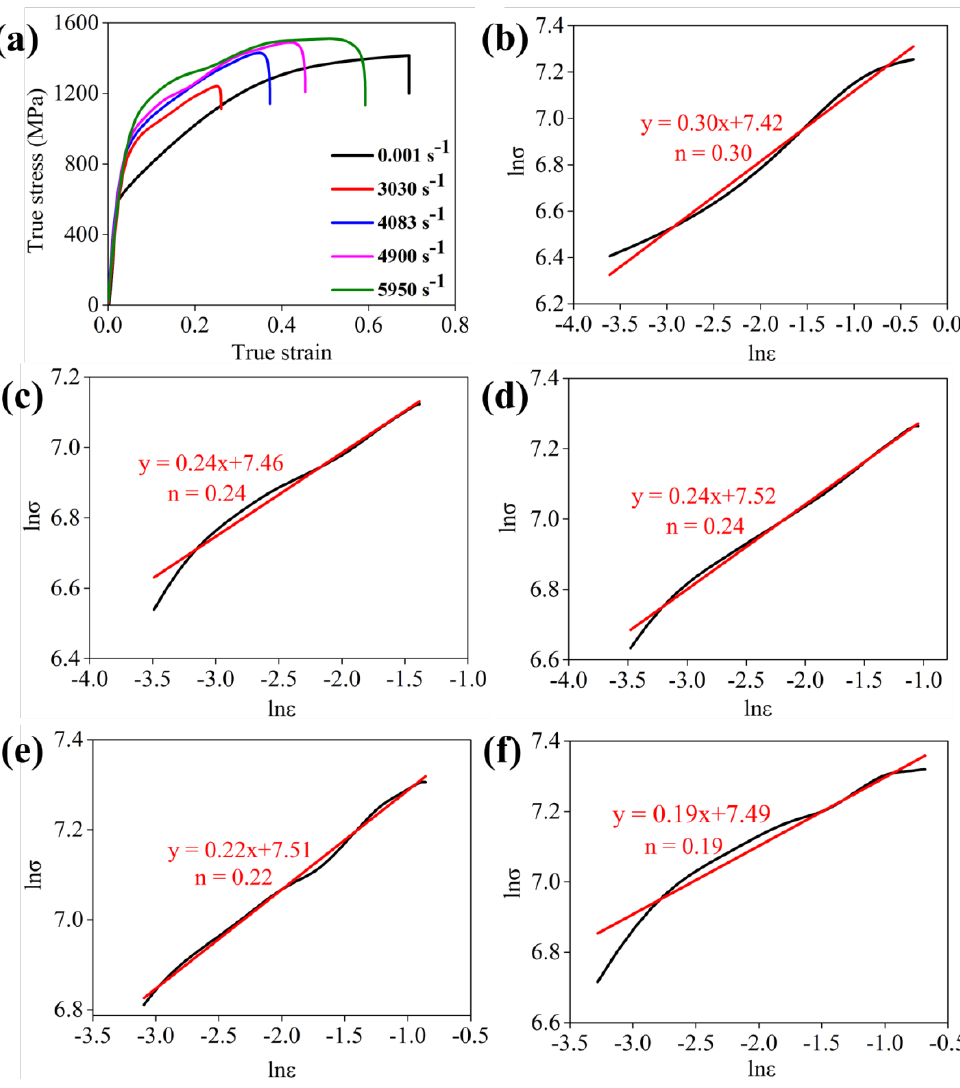
Figure 2. ( a ) Stress – strain curves under given conditions; ( b – f ) strain hardening exponent graphs at 0.001 s − 1 , 3030 s − 1 , 4083 s − 1 , 4900 s − 1 and 5950 s − 1 , In order to evaluate the stress – strain behavior under both conditions, we have eval- uated the strain hardening exponent ( n -value), strain rate sensitivity ( m -value) and adia- batic temperature rise. For evaluating the n-value, the following equation was employed. = n K (1) Here, σ and ε represent true stress and true strain, respectively, K represents the strain hardening coefficient, and n is the strain hardening exponent. By taking the loga- rithm (ln) of Equation (1), we are arrived at; ln ln ln n K = + (2) The value of n can be calculated by making a linear regression analysis of ln σ and ln ε . After thorough analysis, the n -values were evaluated and are shown in Figure 2b – f. The results provided that the n -value ~0.30 is highest in quasi-static compression com- pared to higher strain rates compression. This is well-matched with stress – strain curves. However, n - values are ≥0.19 and approach 0.24 under high strain rate compression, which also assists in understanding the high strain hardenability.